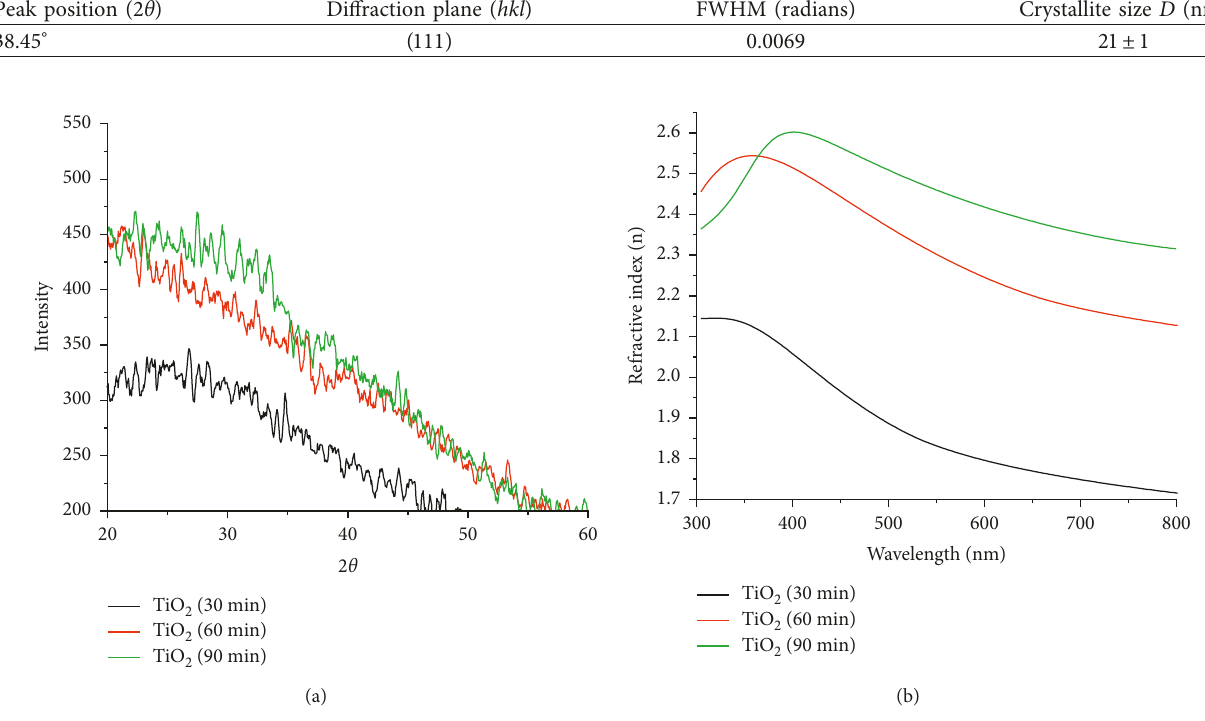
Figure 5: XRD (a) and ellipsometry spectra (b) of TiO Table 2: Calculated refractive indices for different deposition times of TiO